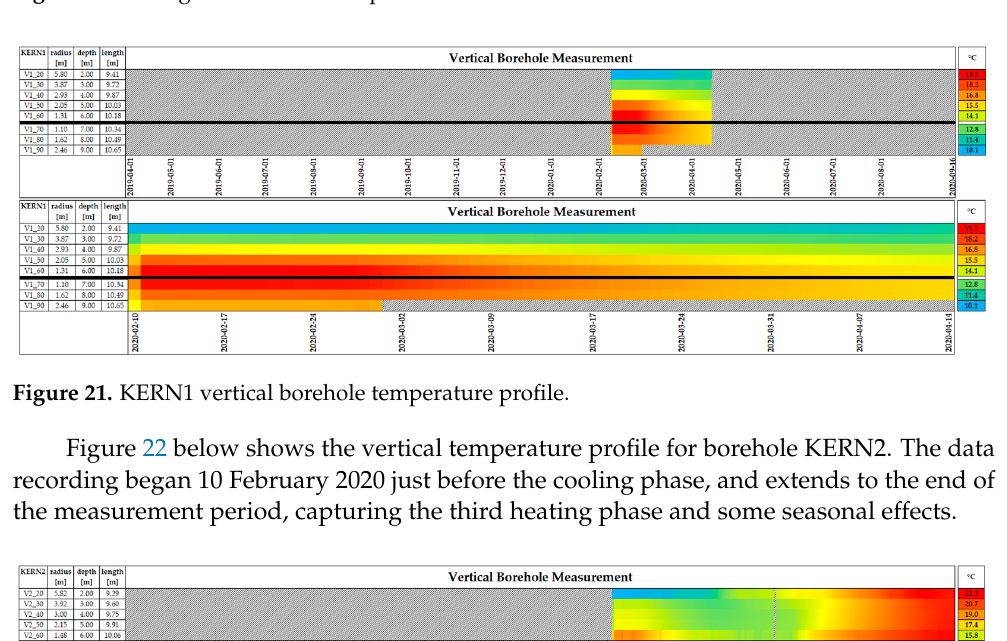
Figure 23. KERN3 vertical borehole temperature profile. 3.2. Model Validation Measurements were conducted to allow validation of the single-bore model. The first heating period was used. The validation of the model was first evaluated on the thermal performance of the inlet and outlet temperatures of the HTF in the heating cell and from the temperature sensors in the measurement boreholes. In situ experimental temperature